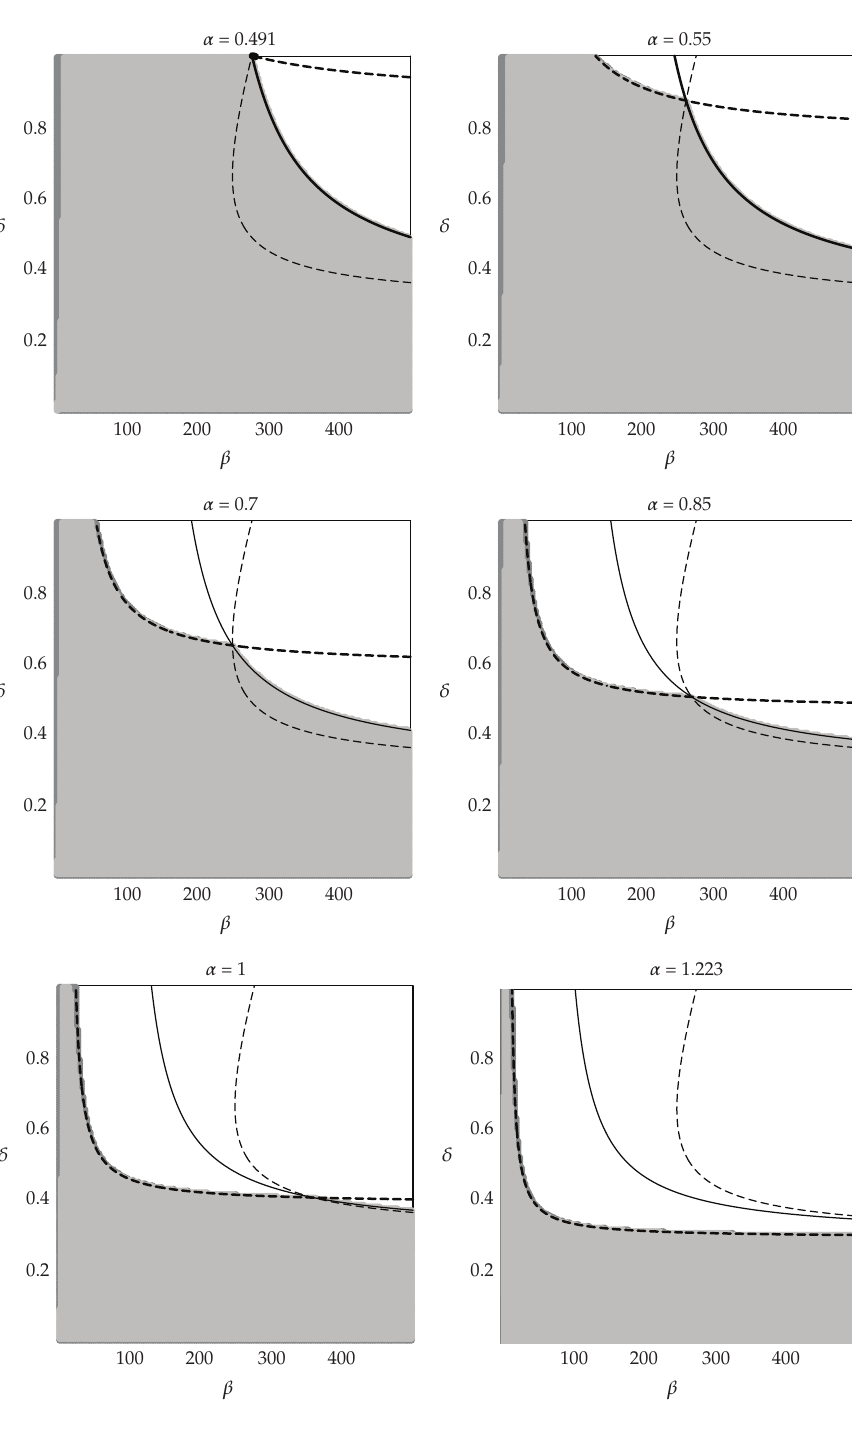
Figure 1: The region of stability of equilibrium in the (cid:4) β,δ (cid:7) plane for γ (cid:9) 1 . 2 and sample values of